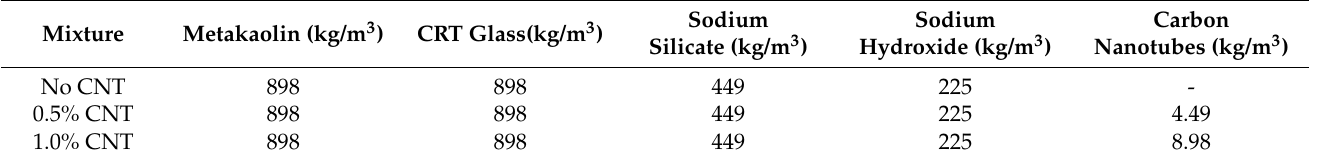
Table 2. Mixtures